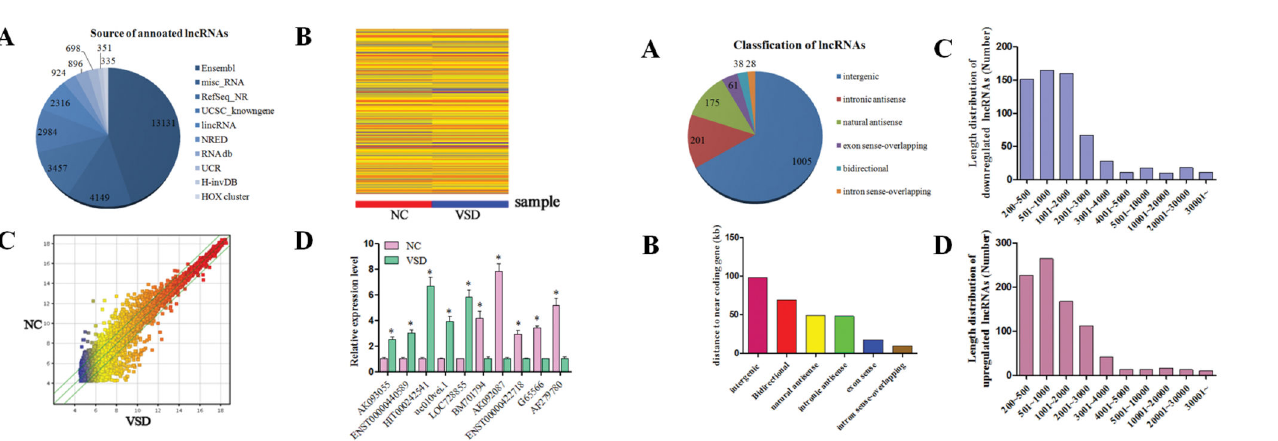
in VSD-affected cardiac tissue. ( A ) Among the dysregulated lncRNAs, there were 905 intergenic, 201 intronic antisense, 175 natural antisense, 61 bidirectional, 38 exon sense and 28 intron sense-overlapping sequences. ( B and C ) The lncRNAs were mainly between 200 bp and 3000 bp in length. ( D ) In accordance with the order from large to small, the distance between lncRNAs and the closest coding gene is intergenic 98 kb, bidirectional 69 kb, natural antisense 49 kb, intronic antisense 48 kb , exon sense18 kb and intron sense- overlapping 10